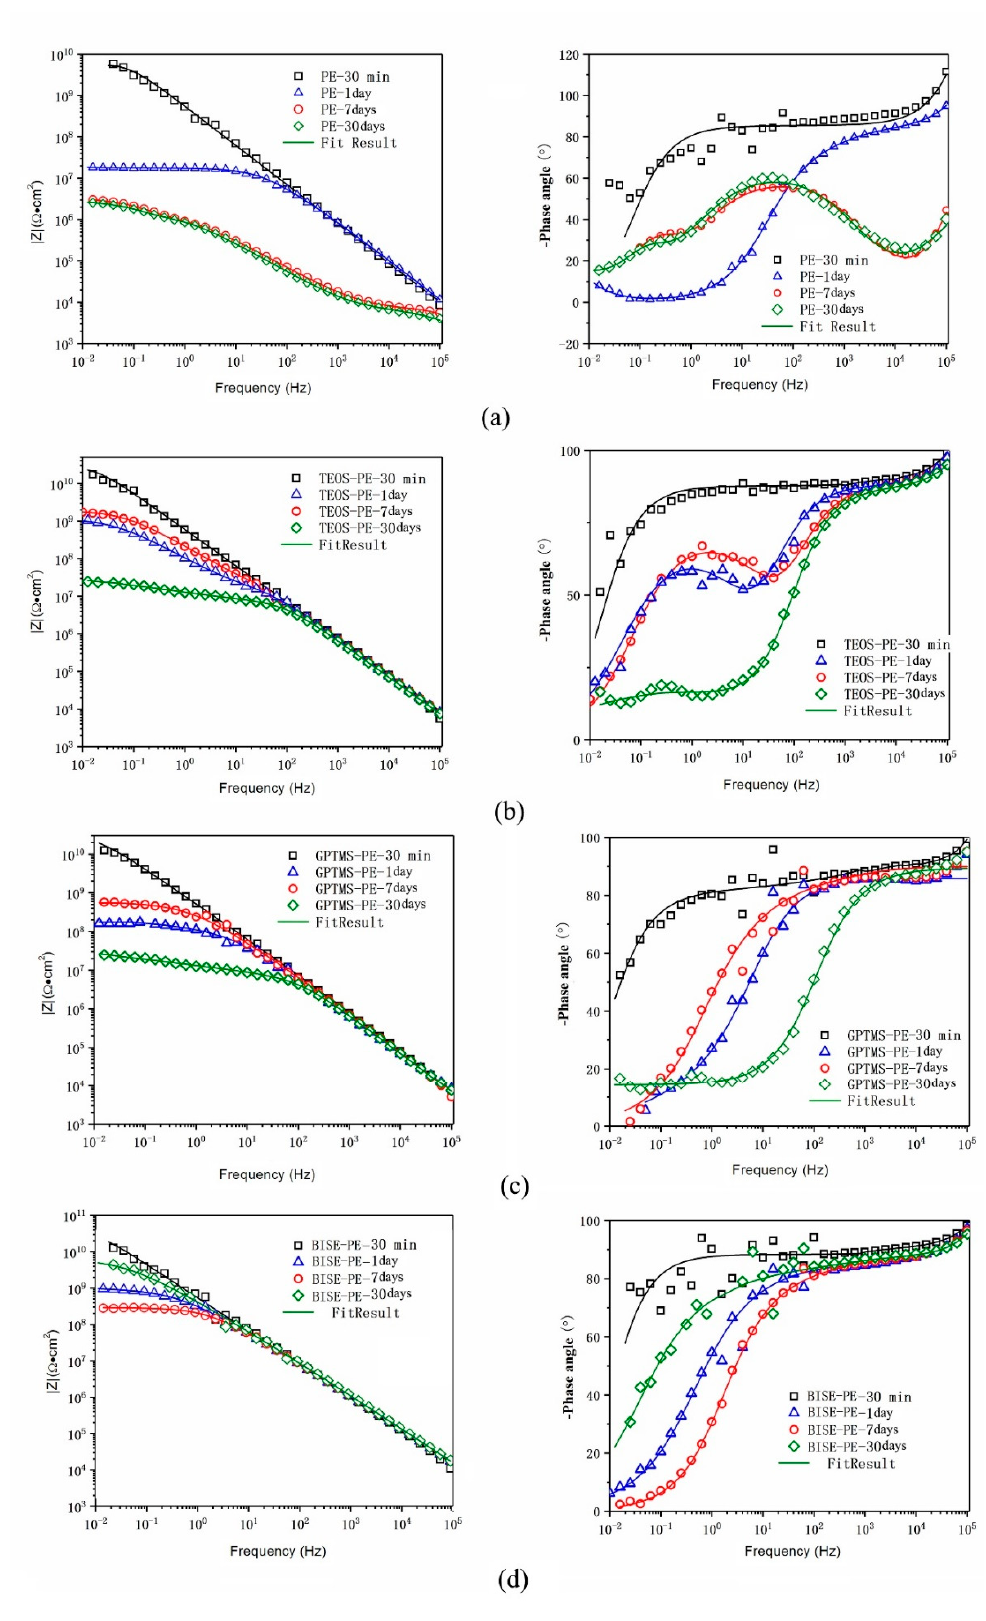
Figure 3. Typical Bode plots of pure ( a ), TEOS − modified ( b ), GMTPS − modified ( c ), and bis − silane ( d ) modified epoxy coatings on Al-alloy during immersion in a 3.5 wt.% NaCl